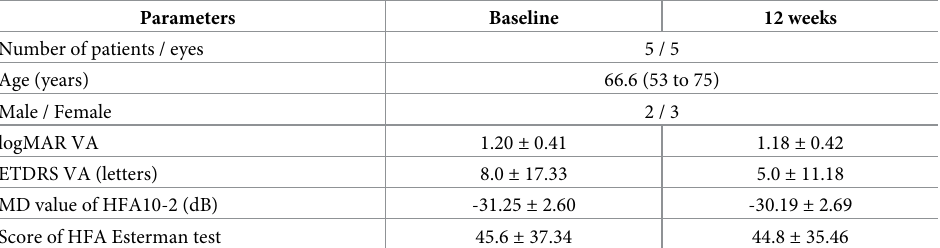
Table 2. Demographic and clinical characteristics at baseline and 12 weeks.